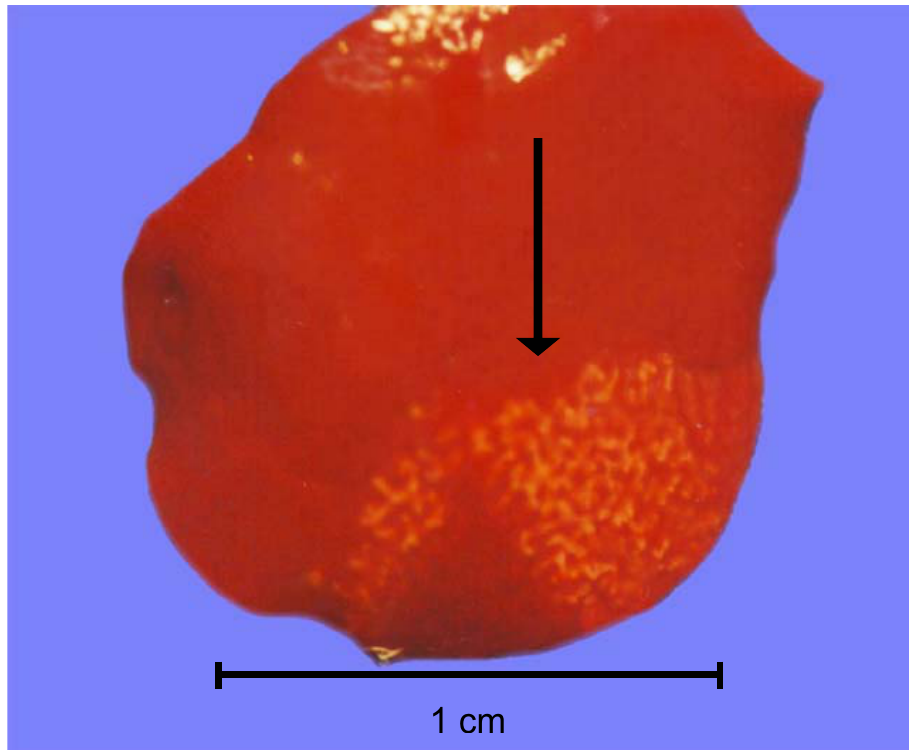
FIGURA 1 – Aspecto macroscópico do fígado de coelho decorridas 24 horas da injeção